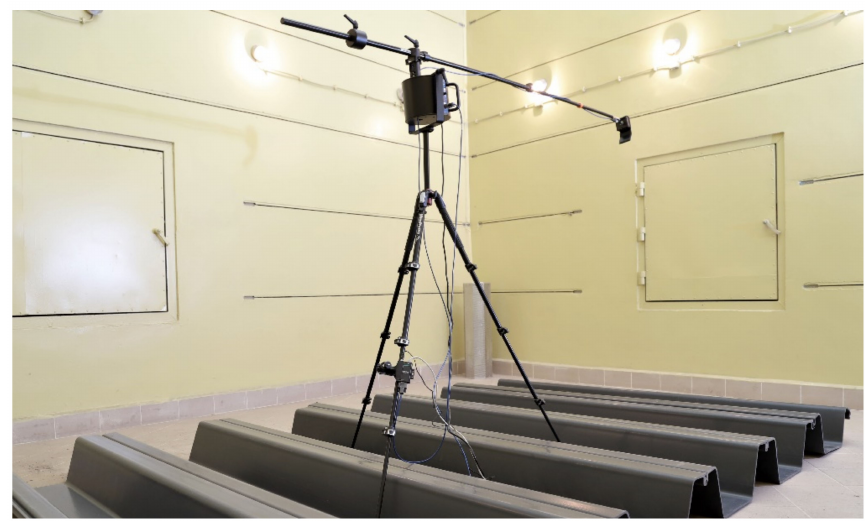
Figure 4. Reverberation room with the studied panel.